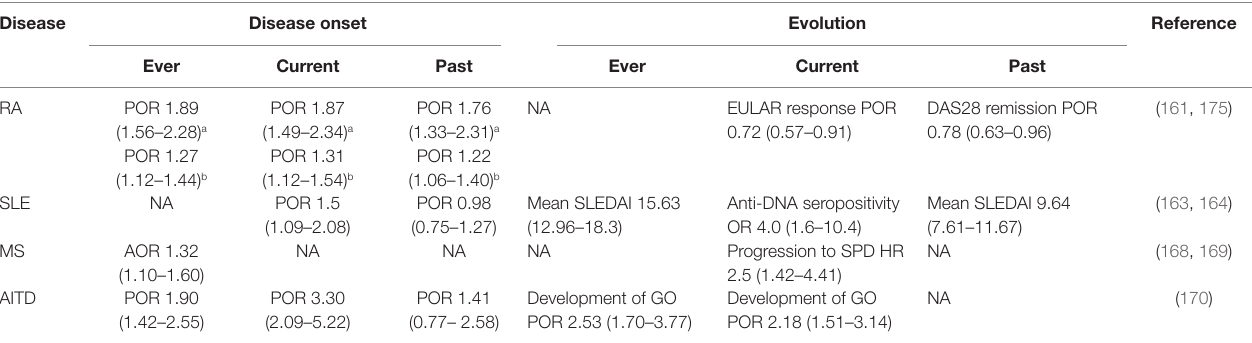
TABLe 5 | Association between smoking status and autoimmune disease onset and evolution.